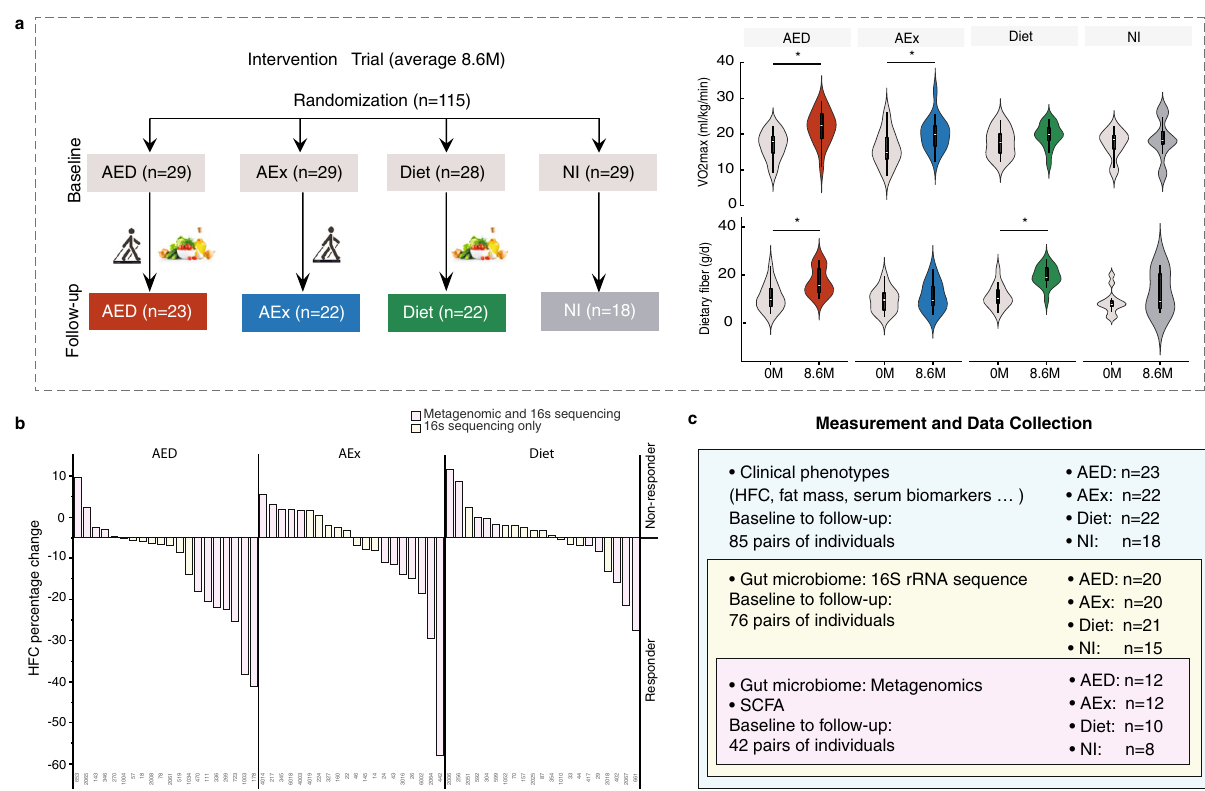
Fig. 1 Summary of clinical study. a Study design. The measurements were performed before and after intervention, and comparison of dietary fi ber intakes and estimated physical fi tness indicated by VO2max before and after intervention are given. The white point, box range, line range and density plot width represent median, interquartile range, 95% con fi dient interval and frequence, respectively. AEx: aerobic exercise; AED: AEx + Diet; NI: no intervention. Comparisons within groups were performed using two-tailed paired t-test. *: Signi fi cance of p < 0.05. b Responders and low/non-responders according to change of HFC (the cutoff value was -5%) after intervention. AED: n = 20, AEx: n = 20, Diet: n = 21. c Data collection. Body fat mass was measured by DXA (dual X-ray densitometry); hepatic fat content (HFC) was determined by 1 HMRS (proton magnetic resonance spectroscopy); fecal samples were collected for microbiome assessments with both 16 s rRNA and metagenome assessments; and blood samples were used for clinical biomarkers